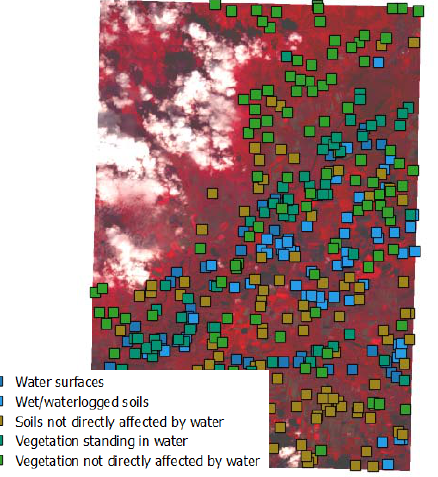
Figure 3. Distribution of categorized point dataset (reference) for the study area A.